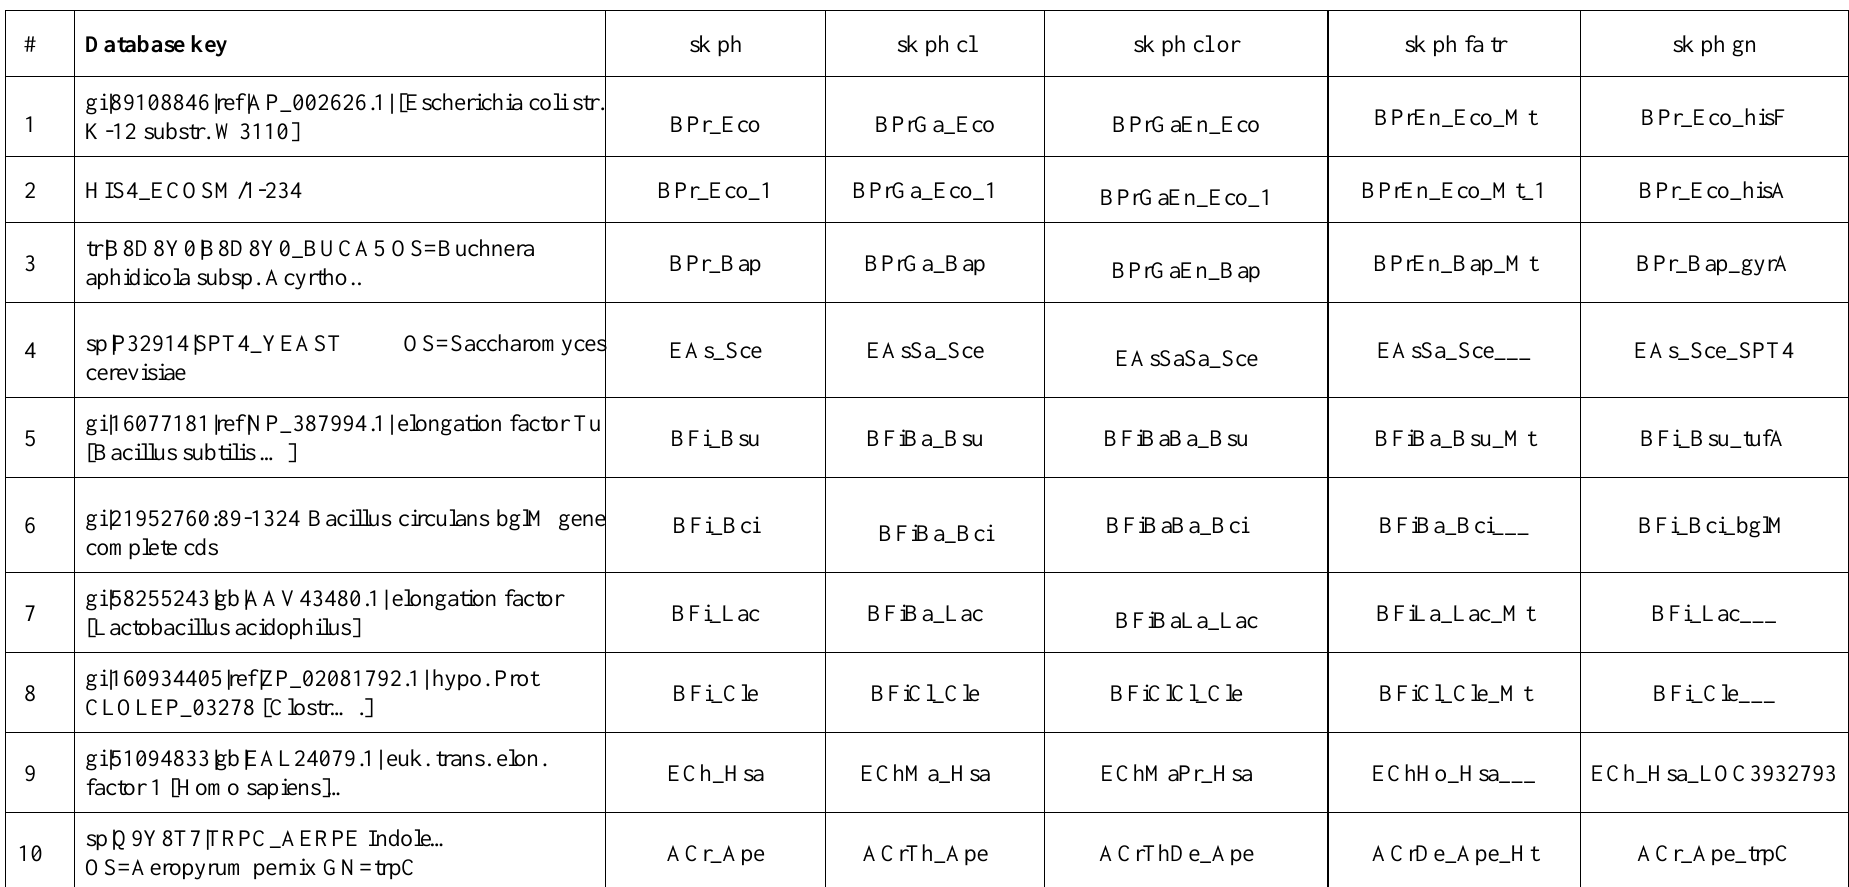
Tab. 2: Labels generated by Key2Ann. Column 1 lists the number of the respective key. The database keys are from DNA (#6) and from protein sequences (all others). Entry #2 is from the Pfam database, #4 and #10 are from SwissProt, all other ones are from NCBI databases. Some keys are abbreviated versions, indicated by “…”. The following columns give the output generated by different combinations of command line arguments. Arguments are abbreviated according to sk = superkingdom , ph = phylum , cl = class , or = order , fa = family ; tr = temprange and gn = gene indicate two options adding the temperature range of the habitat or the gene name. The prefix for the phylogenetic lineage is supplemented by a three letter infix deduced from the name of the species. E. g. “Eco” is for Escherichia coli and “Hsa” for Homo sapiens . The infixes “Mt” and “Ht” indicate mesophilic and hyperthermophilic species. Properties that cannot be resolved are indicated by